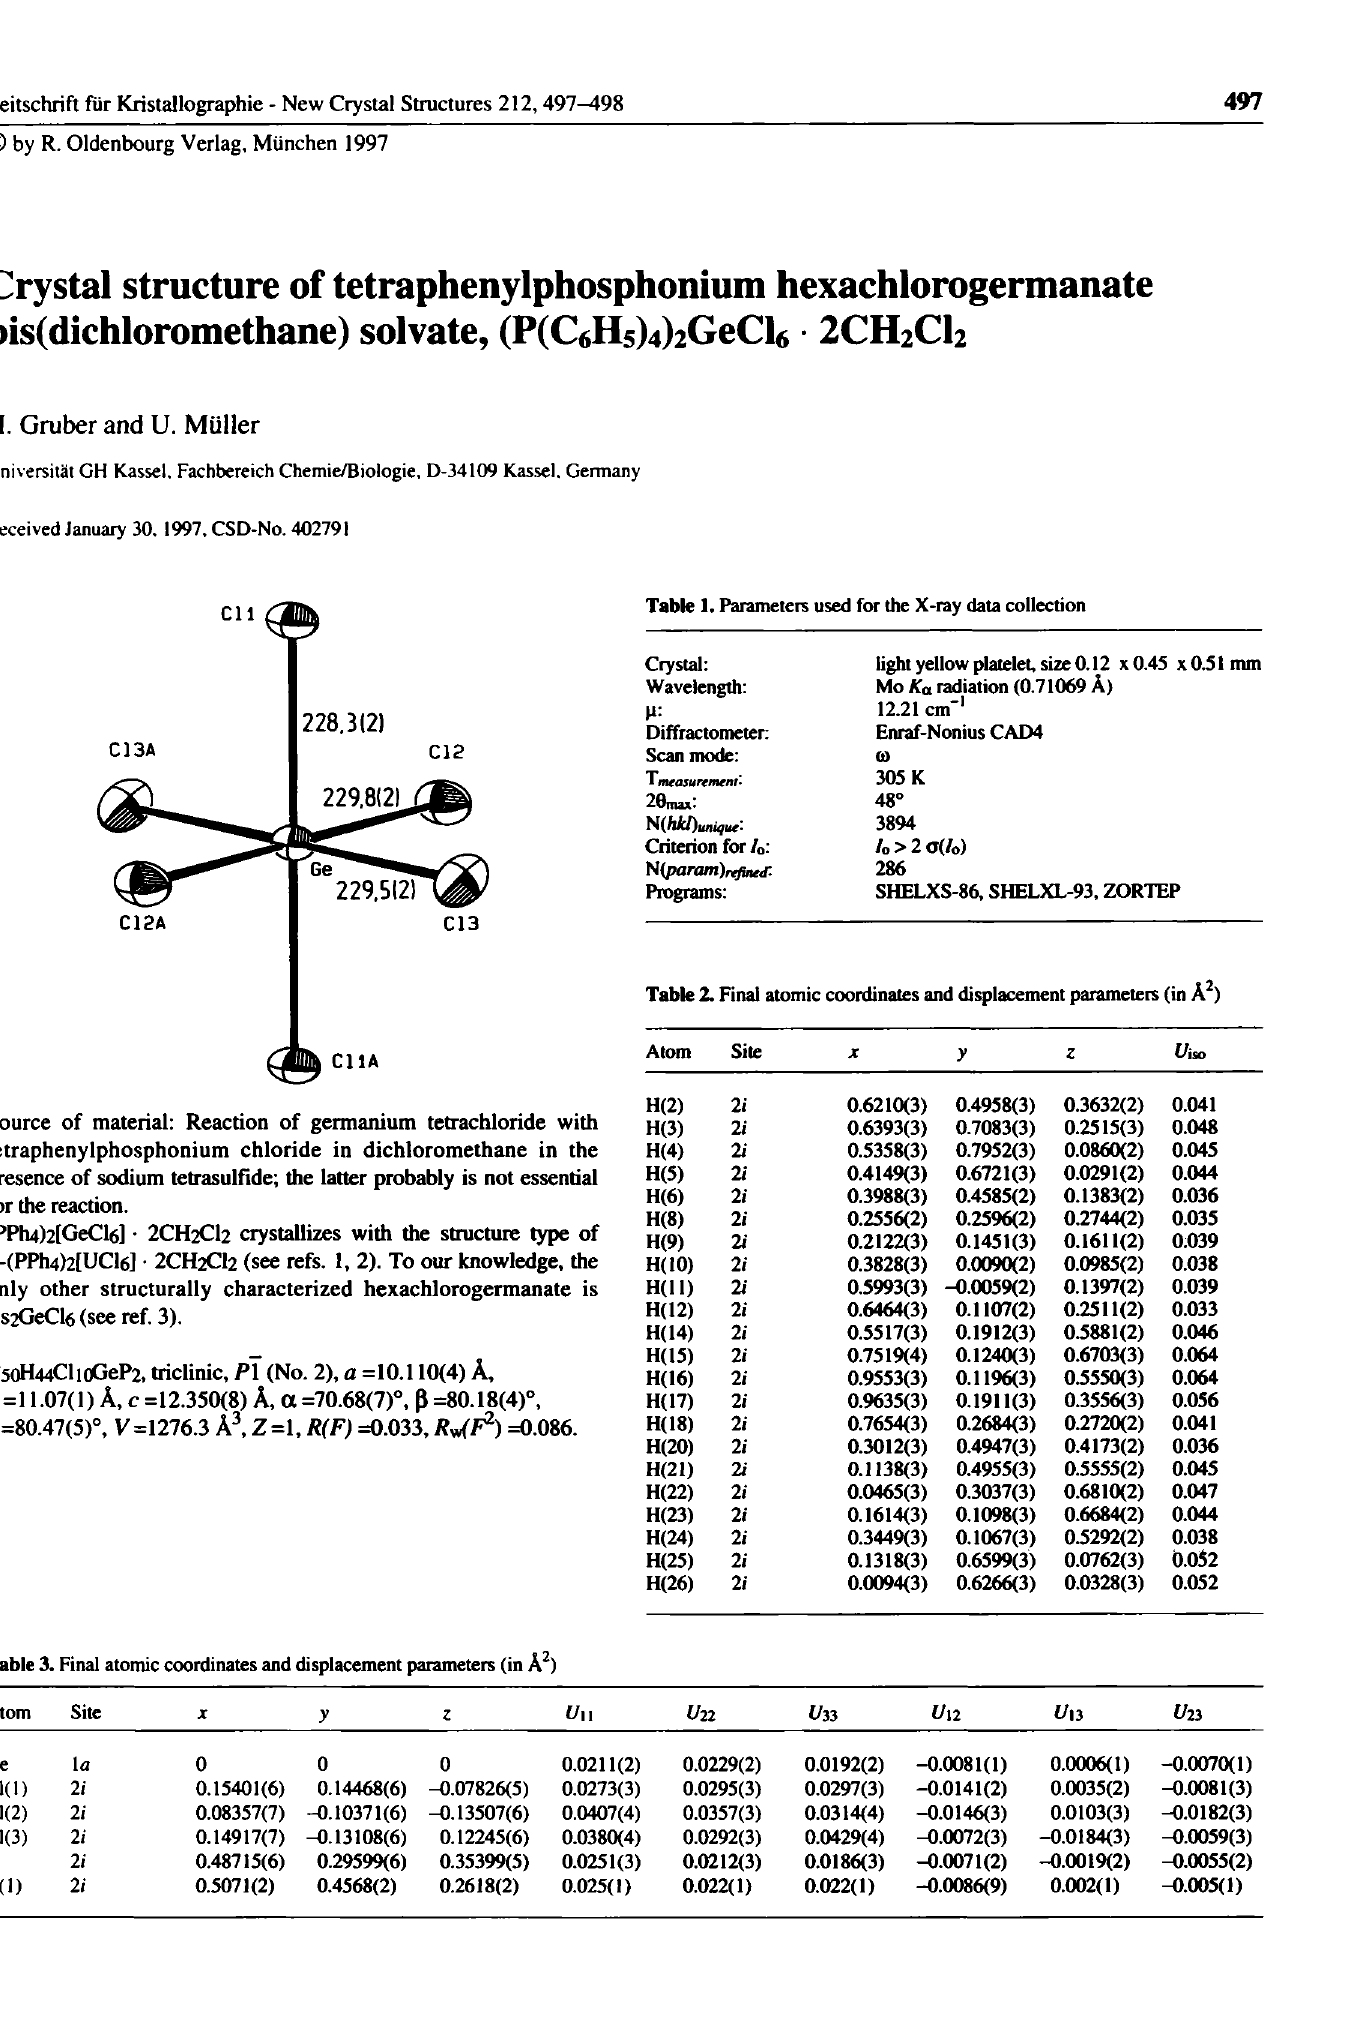
Table 3. Final atomic coordinates and displacement parameters (in Â 2 ) Atom